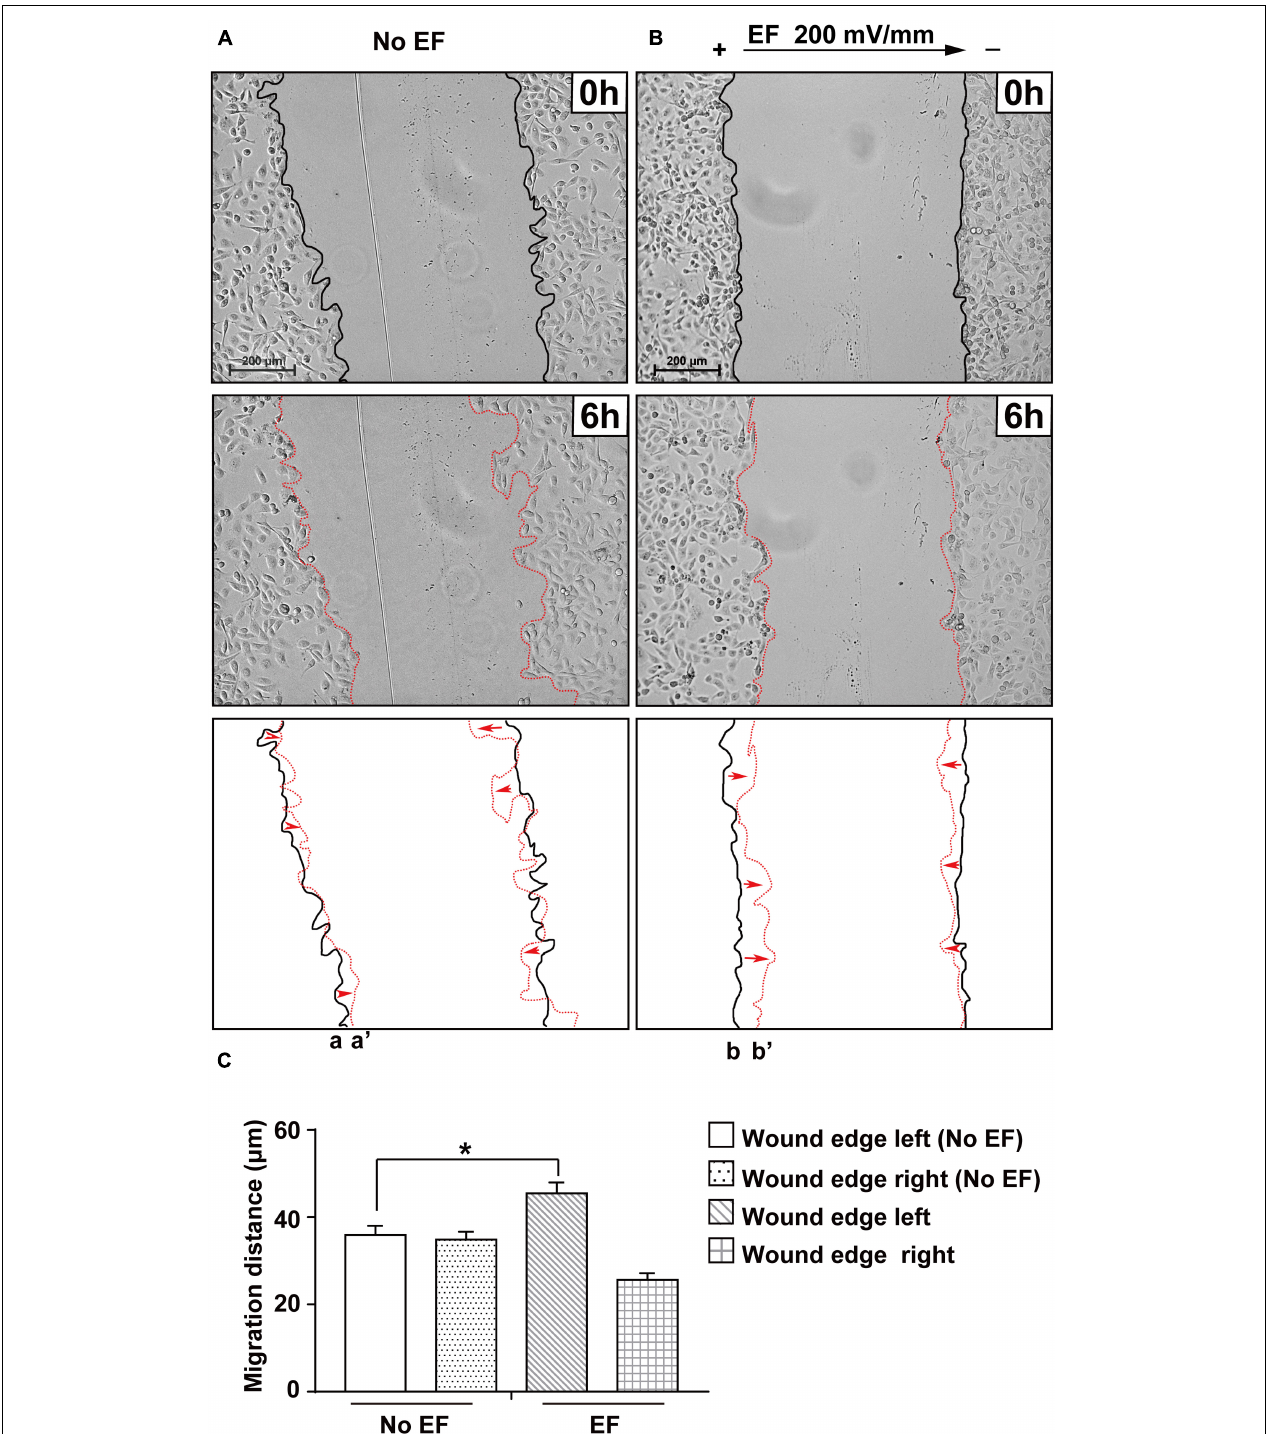
FIGURE 3 | Effect of EF stimulation on wounded human renal tubular epithelial monolayer migration. Confluent renal cellular monolayers were wounded and cultured in EF for 6 h at a field strength of 200 mV/mm. The presence of EF significantly enhanced the cell sheet of the cathode-facing side moving toward the cathode (b to b’) during a 6 h culture period (B) , while the no EF control showed a similar wound closure rate of cell sheets on either side (toward the center of the culture) (A) . Polarity is as indicated; the cathode is at right. Bottom panels show the outlines of the wounded monolayers front at the beginning and end of each experiment with migration direction indicated by the arrows. Scale bar = 200 µ m. * P < 0.05, compared to the same edge of the control with no EF (0 mV). (C) Quantification of the cell migration distance of wound edges in different treatment groups (with and without EF stimulation).